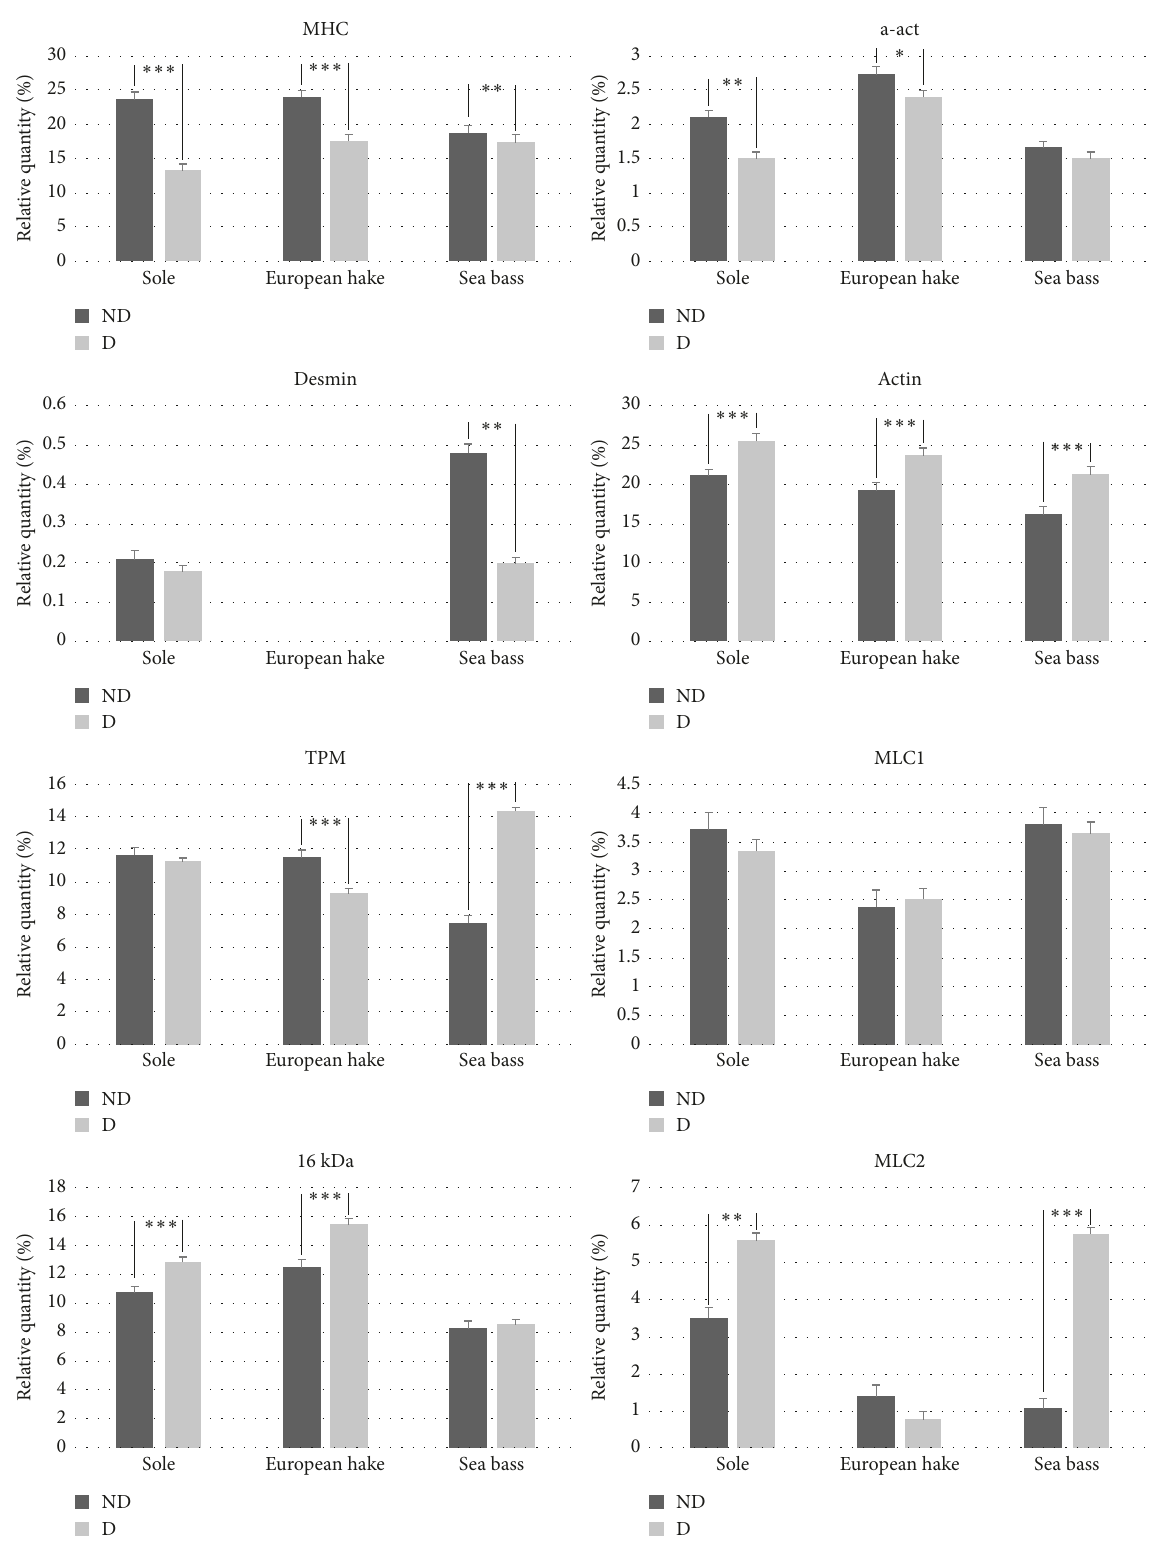
Figure 6: Percentage of the main myofibrillar proteins from sole, European hake, and sea bass samples extracted with denaturing and nondenaturing solutions (D � denaturing; ND � nondenaturing; MHC � myosin heavy chain; a-act � α -actinin; TPM � tropomyosin; MLC1 � myosin light chain 1; MLC2 � myosin light chain 2; ∗ P < 0 . 05; ∗∗ P < 0 . 01; ∗∗∗ P < 0 . 001) (means ±